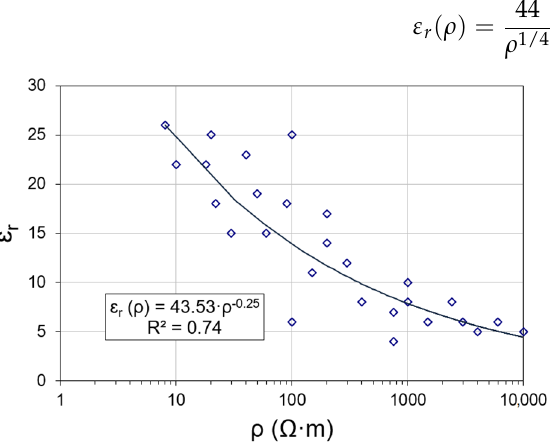
Figure 12. ◊ Relative permittivity versus resistivity values in different media and the least squares approximation curve.